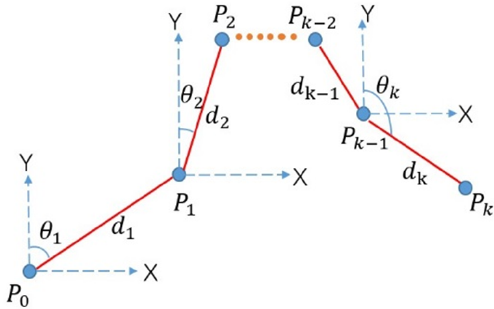
Figure 2. Coordinate calculation of each step in PDR.